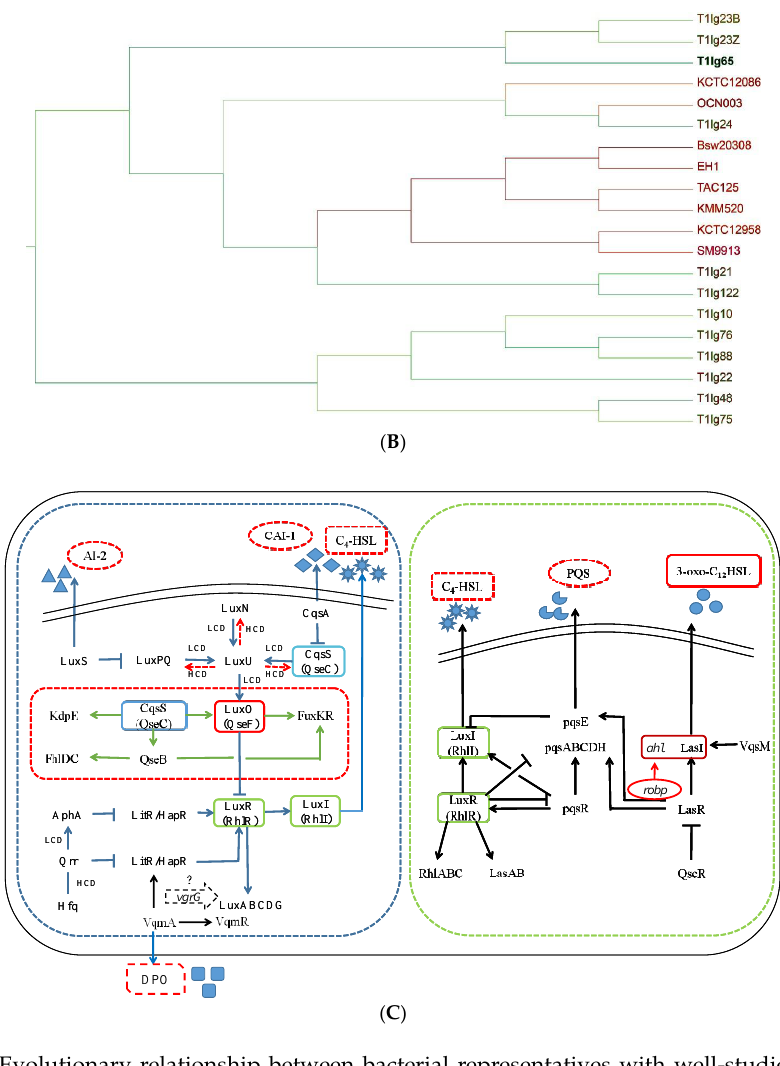
Figure 2. Evolutionary relationship between bacterial representatives with well-studied quorum sensing regulon and quorum sensing working model proposed from Pseudoalteromonas . ( A ) Schematic presentation of evolutionary relationship among Pseudoaltermonas , Vibrio , Pseudomonas, and Escherichia coli based on phylogenetic analysis of concatenated protein-coding sequences. Representative QS regulon in each clade was indicated if applicable: LuxR/HapR in V.cholerae V52 and V. parahaemolyticus RIMD 2210633; QseB/QseC in E. coli O157:H7; LasI/LasR in P. aeruginosa PAO1, P. putid a KT2440 and P. syringae pv. tomato strain DC3000. ( B ) Pseudoalteromonas phylogeny. Fully-sequenced Pseudoalteromonas strains in this phylogeny: Pseudoalteromonas phenolica KCTC 12086: chr1 (CP013187), chr2 (CP013188); Pseudoalteromonas sp. OCN003: chr1 (CP009888), chr2 (CP009889); Pseudoalteromonas sp. Bsw20308: chr1 (CP013138), chr2 (CP013139); Pseudoalteromonas aliena EH1: chr (CP019628); Pseudoalteromonas haloplanktis TAC125: chr1 (CR954246), chr2 (CR954247); Pseudoalteromonas translucida KMM 520:chr1 (CP011034), chr2 (CP011035); Pseudoalteromonas issachenkonii KCTC 12958: chr1 (CP013350); chr2 (CP013351); Pseudoalteromonas sp. SM9913: chr1 (CP001796); chr2 (CP001797). ( C ) Quorum sensing working model proposed from Pseudoalteromonas . The blue panel on the left in the working model schematics shows the QS system in Vibri o [11,12,33–39], whereas the red panel for that of E. coli [12,33] . The large light green dotted box presents the QS regulators in Pseudomonas aeruginosa [40–43]. Arrows indicate positive regulation (activation) and T-bars indicate negative regulation (inhibition). Red dotted arrows indicate positive regulation at high cell densities. Triangle represents signal molecule AI-2, diamond represents signal molecule CAI-1, and polygon represents signal molecule C4-HSL, together with 3/4 donut and droplet indicating signal molecule PQS and 3-oxo-C 12 -HSL, respectively (molecules with dotted line indicating non-AHL signals). Box represents signal molecule DPO